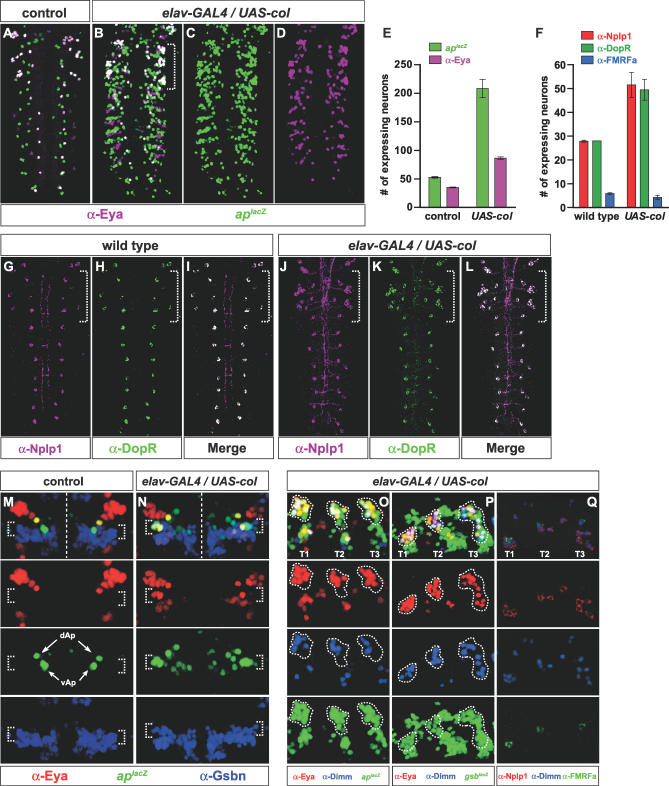
Misexpression of col Activates ap, Eya, Dimm, Nplp1, and DopR, but in a Context-Dependent Manner(A–L) Expression of aplacZ, Eya, Nplp1, DopR, and FMRFa in 18-h AEL control and col misexpression VNCs. (A) In the control, aplacZ and Eya are specifically expressed in Ap neurons. A small number of additional Eya-expressing cells are visible laterally; these cells express Eya at earlier stages, but typically down-regulate Eya expression at stages 15/16 [12].(B–D) In col misexpression embryos, robust ectopic expression is evident for both aplacZ and Eya, although ectopic co-activation of aplacZ and Eya genes is predominantly apparent in lateral thoracic areas (bracket).(E) Quantification of aplacZ and Eya expression (n > 3 VNCs).(F) Quantification of Nplp1, DopR, and FMRFa expression (n > 8 VNCs). There is no evidence of ectopic FMRFa expression.(G–I) In the wild type, Nplp1 and DopR expression is evident in dAp and Tvb neurons.(J–L) col misexpression leads to ectopic co-activation of Nplp1 and DopR expression, again restricted to lateral thoracic areas (brackets).(M and N) col misexpression triggers ectopic co-activation of aplacZ and Eya at stages earlier than when Ap clusters are normally generated (dashed lines depict the VNC midline). In the control (M), only dAp (aplacZ/Eya expressing) and vAp (aplacZ expressing) neurons are visible at stage 14. (N) In col misexpression, ectopic aplacZ and Eya cells, as well as double-positive cells, appear earlier and increase in numbers into stage 14 (brackets).(O–Q) Lateral view of the three thoracic segments in 18-h AEL VNCs; anterior is to the left. (Dotted circles depict the enlarged Ap cluster.) (O) col misexpression leads to appearance of six to ten aplacZ/Eya-expressing cells, of which a subset is also Dimm expressing, and (P) these ectopic “Ap cluster” cells are confined to row 5, i.e., the anterior region of gsblacZ expression. (Q) col misexpression triggers ectopic Nplp1 in these ectopic Dimm cells, while FMRFa is still only expressed in one cell per hemisegment.Genotypes: (A and M) aplacZ/+; elav-GAL4/+,  (B–D, N, and O) aplacZ/+; elav-GAL4/ UAS-col/+, (G–I) w1118, (J–L) elav-GAL4/UAS-col, and (P–Q) gsblacZ/+; elav-GAL4/ UAS-col/+. (E) Control is aplacZ/+; elav-GAL4/+, and (F) control is w1118.